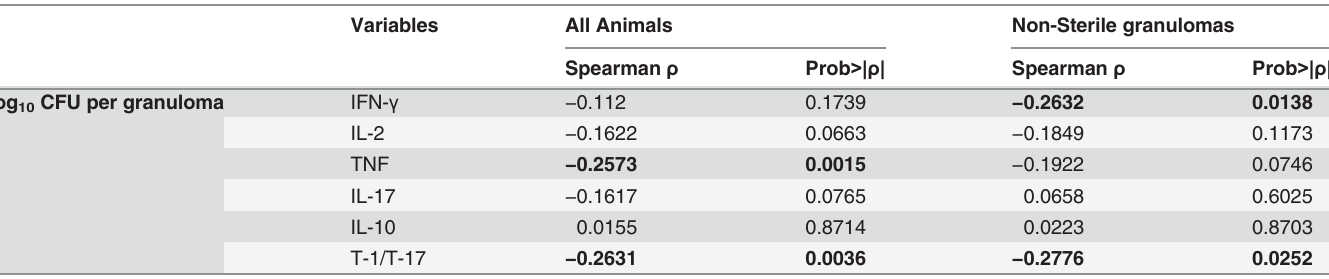
Table 2. Correlation between granuloma bacterial burden and T cell cytokine response. Variables All Animals Non-Sterile